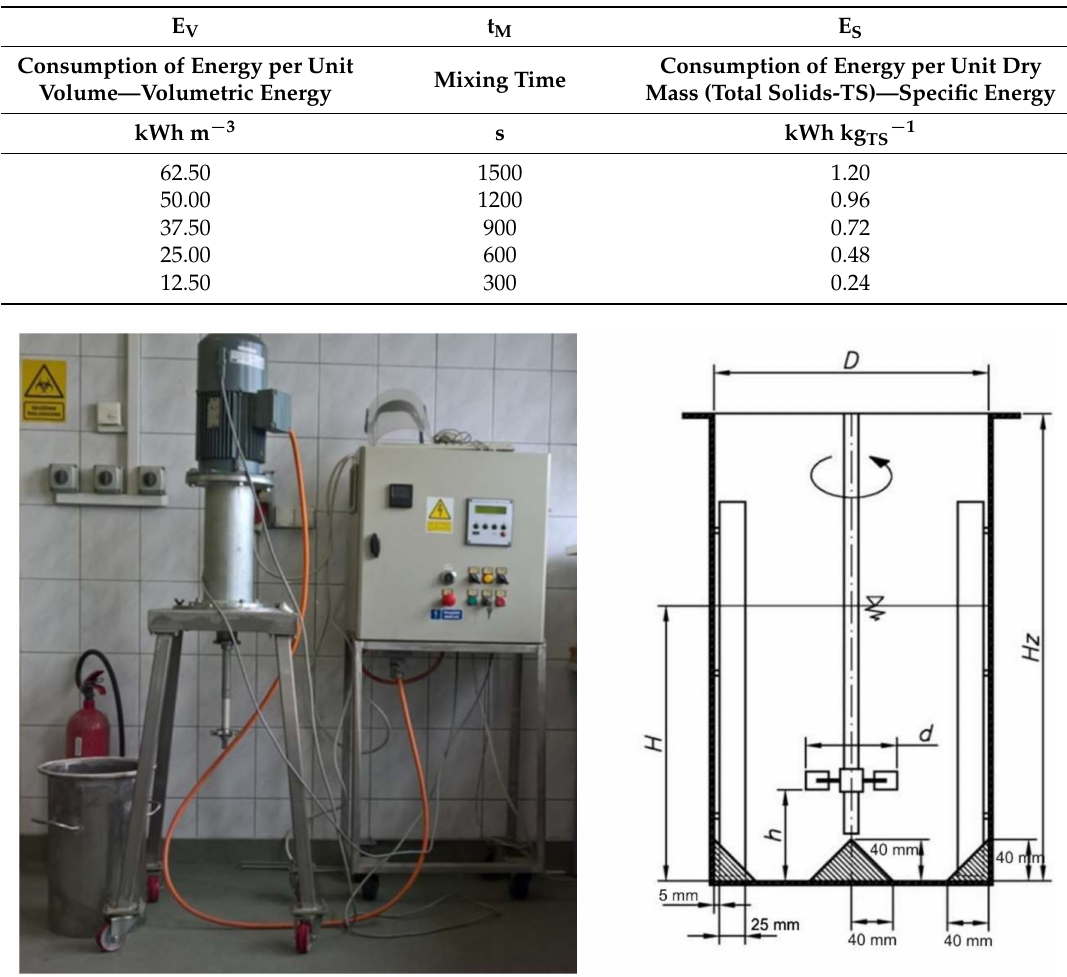
Figure 2. Semi-technical sludge disintegrating mixer setup (photo and scheme [24])—sludge mixer, stand, control